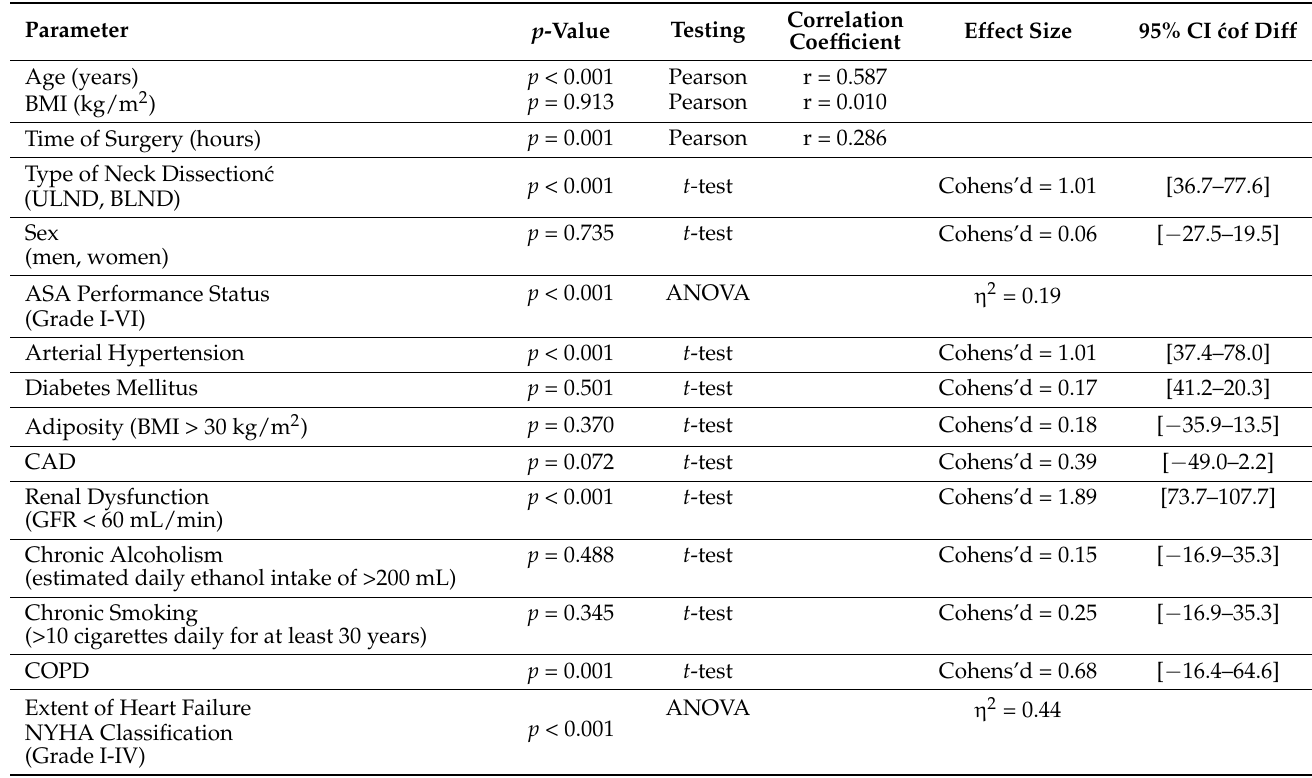
Table 5. Separate single testing of parameters in correlation to ICU-LOS. The table shows the calculation of single parameters that were set in correlation to ICU-LOS separately. This calculation does not control multiple possible confounders from other co-variables such as sex, age, type of neck dissection, tumor localization etc. The variety of multiple possible confounders that may additionally influence ICU-LOS in parallel was considered in the regression model in Table 4. Mean values of analyzed parameters and values of ICU-LOS are also included in Table 4. The statistical methods used in this table are given in detail in the material and methods section of the